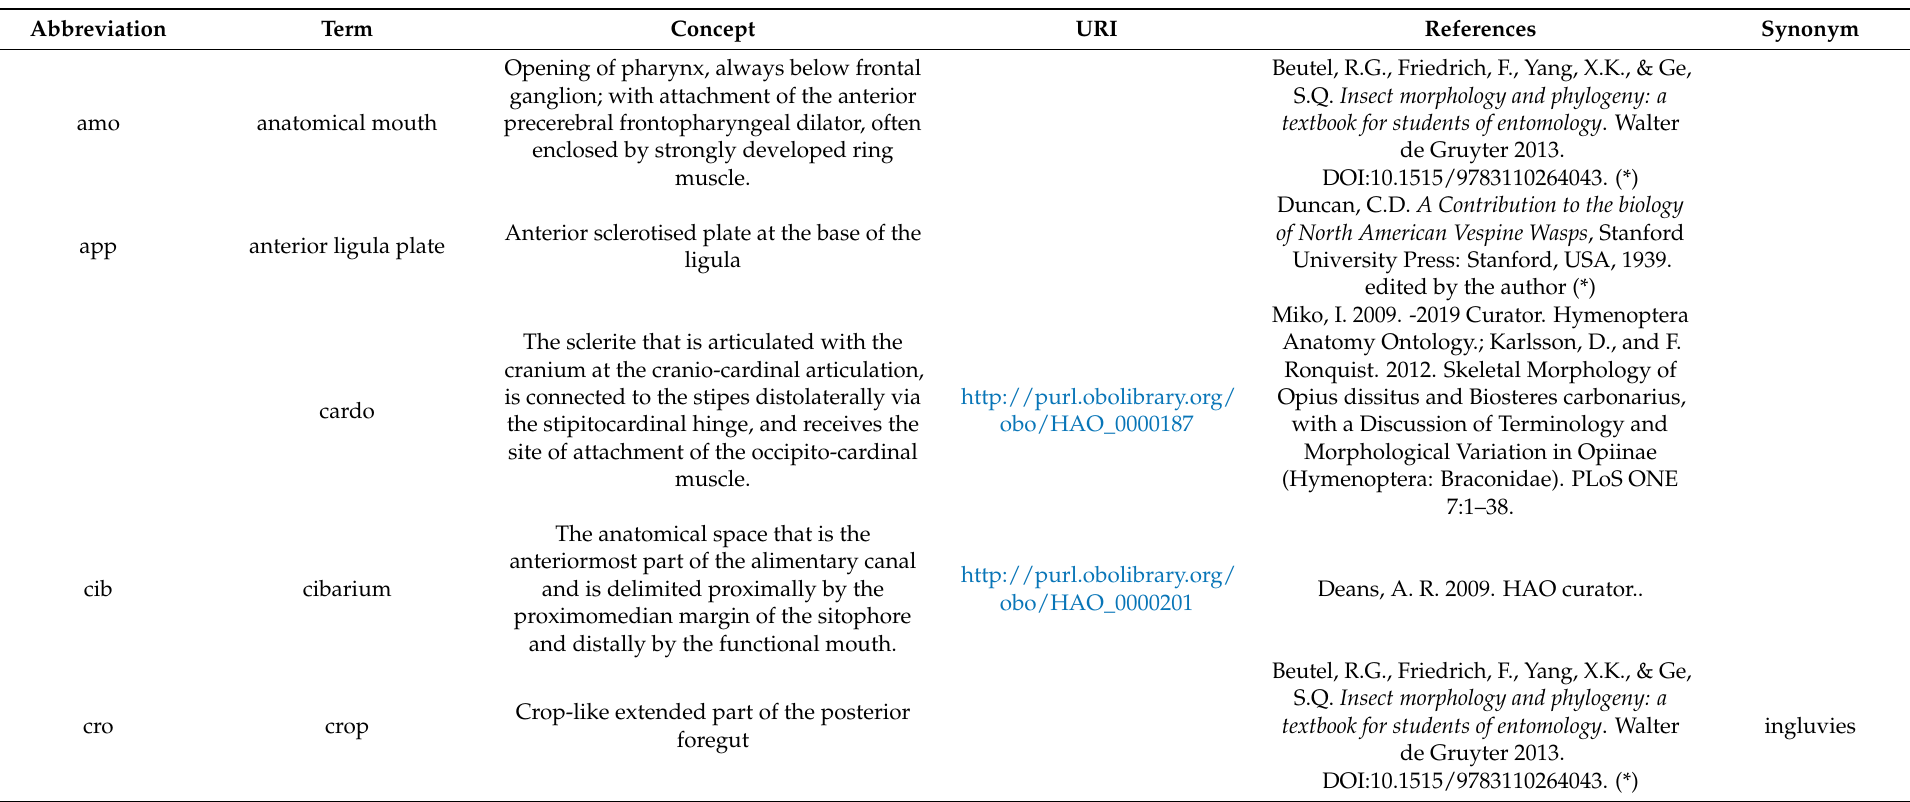
Table A1. As there is a certain potential for confusion, when dealing with morphological terms, which has also been noted by a reviewer, we include this table with a list of abbreviations, terms, concepts, sources, and synonyms. Thanks to the authors of the http://portal.hymao.org/projects/32/public/ontology/ (accessed